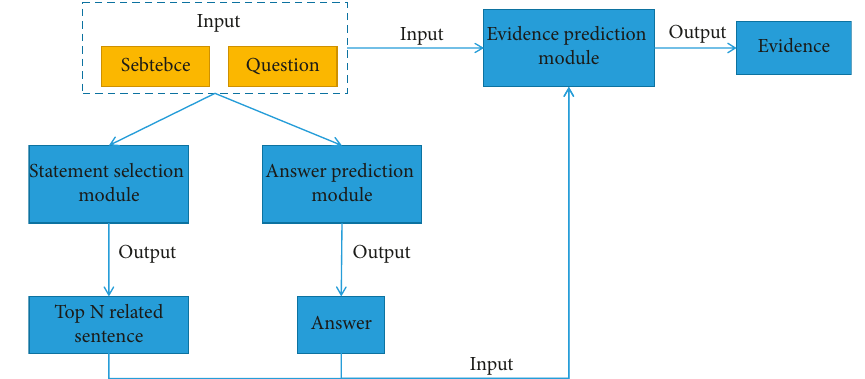
Figure 6: Model flowchart during